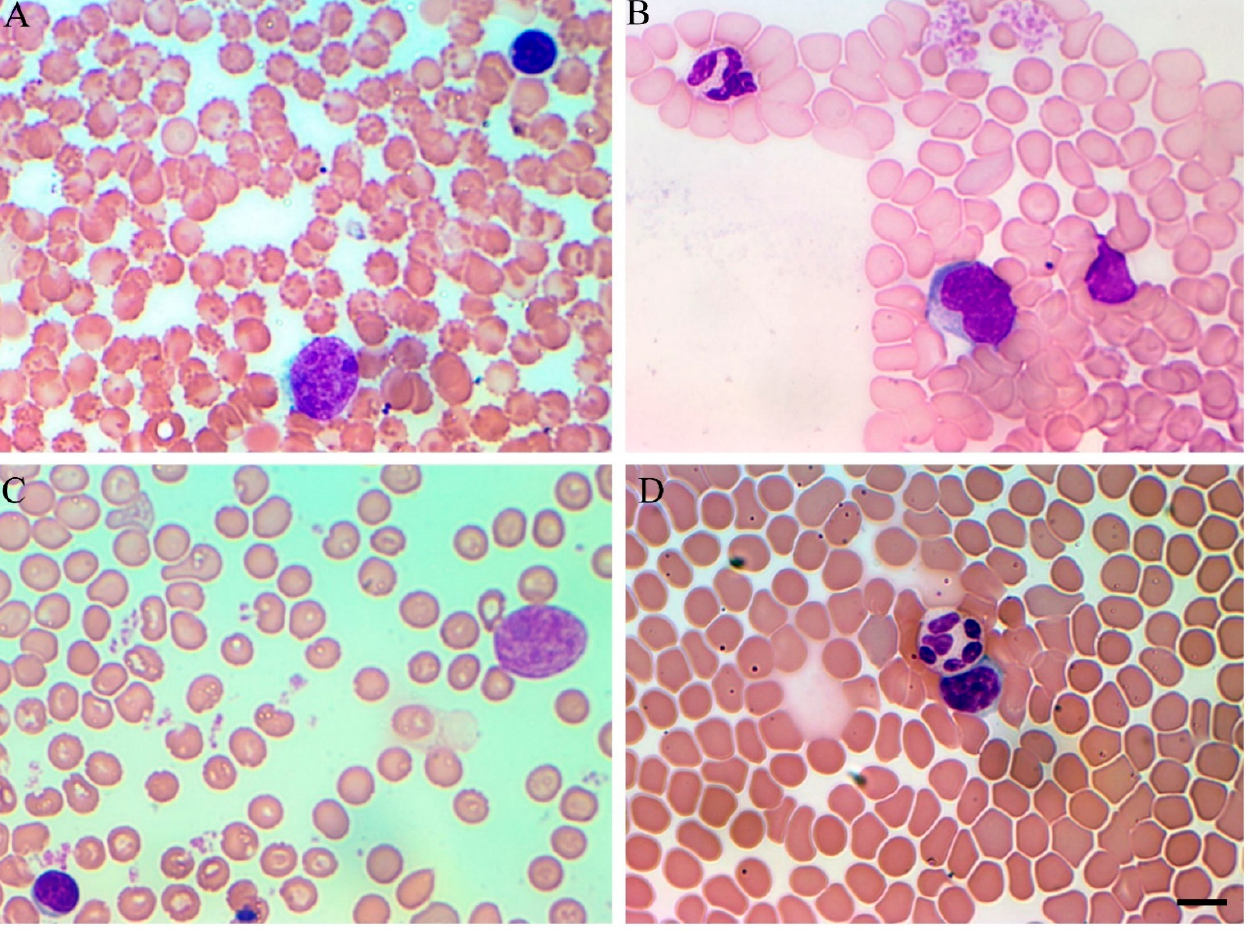
Figure 5. Blood smears in SARS-CoV-2 infected Syrian hamsters (Giemsa stained). ( A ) Lymphoblasts at 2nd dpi (finely expressed nucleoli inside the nucleus) ( B ) Monoblast at 1st dpi. ( C ) Myeloid cell at 3rd dpi. ( D ) Hypersegmented neutrophil at 3rd dpi. Scale bar for ( A – D ) 10 μ m. Along with early stages of cells, pathological cells (such as hypersegmented neutro- phils—Figure 5D) also appear in the blood of SARS-CoV-2 infected animals (Table 2). Table 2. Blood cells populations in norm and under the action of SARS CoV-2.